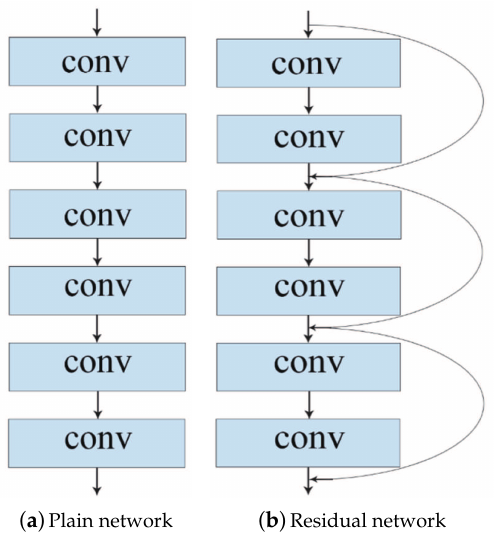
Figure 8. Architectures of the plain network and residual